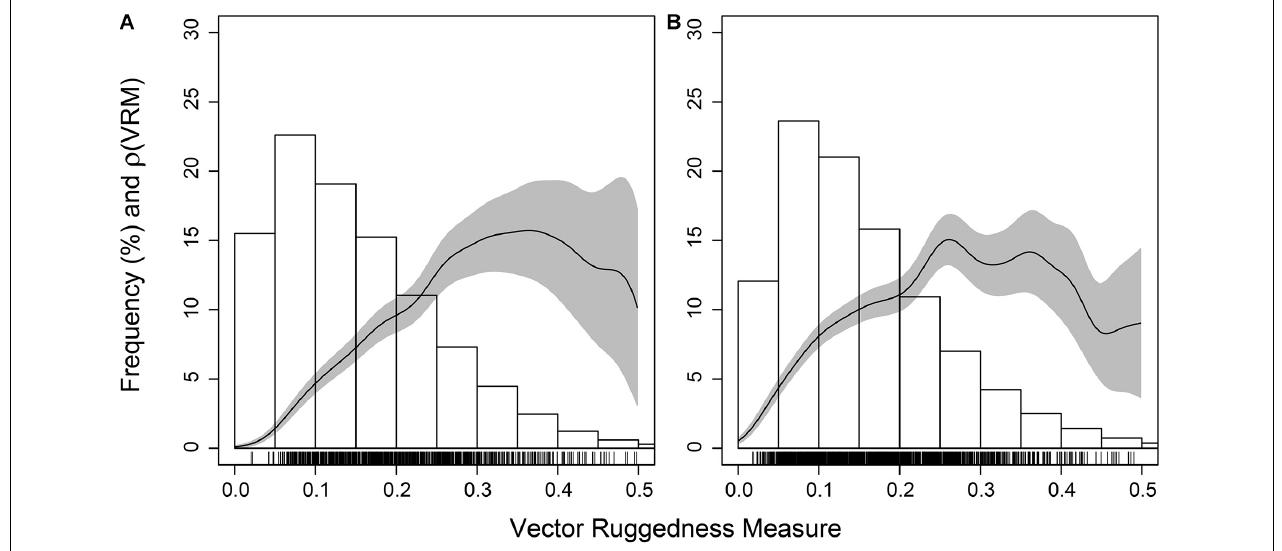
FIGURE 12 | Estimated function ρ ( VRM ) giving the estimated Aphrocallistes sp. intensity as a function of Vector Ruggedness Measure at Site A (A) and B (B) . Grey represents 95% confidence bands. Bars refers to frequency as a percentage of coral substrate